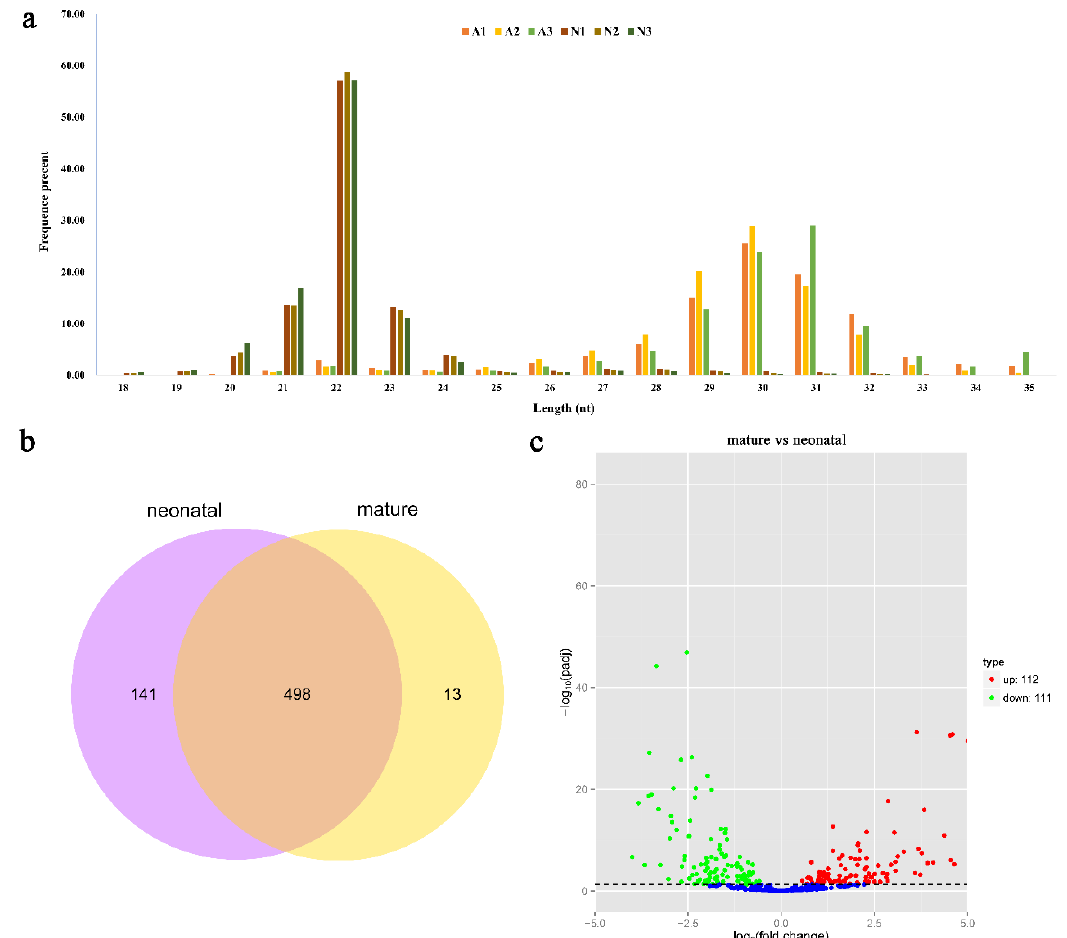
Figure 1. Sequencing and bioinformatics analysis results of miRNA in bovine testis. ( a ) The length distribution of small RNA library in six bovine testes. ( b ) Venn diagram showing overlap of miRNAs among neonatal and mature bovine testes. ( c ) Differential miRNA expression between neonatal and mature bovine testes. Volcano plots showing –log10 ( p-adj value) versus log 2 (fold change) difference in miRNA abundance in TPM (transcript per million) between neonatal and mature bovine testis. Red circles denote significantly overexpressed miRNAs, whereas green circles denote significantly underexpressed miRNAs in mature bovine testis when compared to the neonatal group. The cut off values ( p-adj value < 0.05 and |log2fold-change| > 1) are selected for the differentially expressed (DE) analysis.